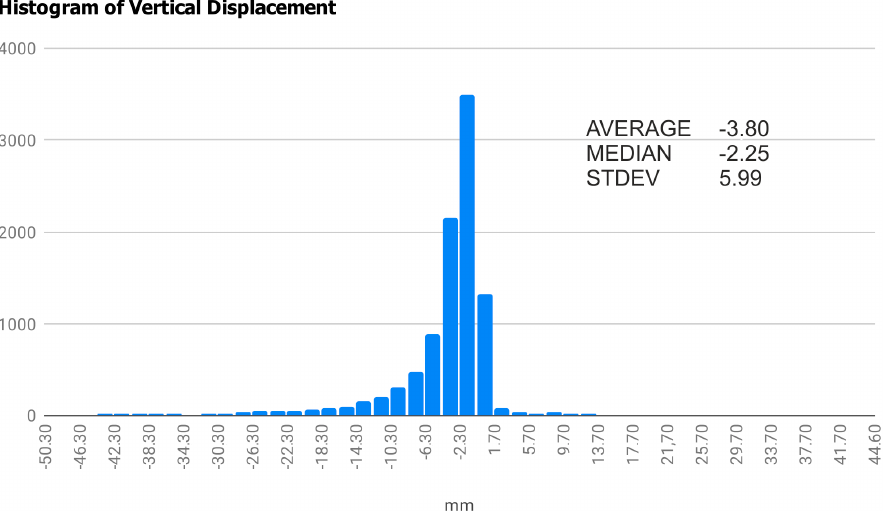
Figure 8. Histogram of vertical displacement dataset during the period from 22 February 2017 to 17 May 2017 complemented by descriptive statistics.